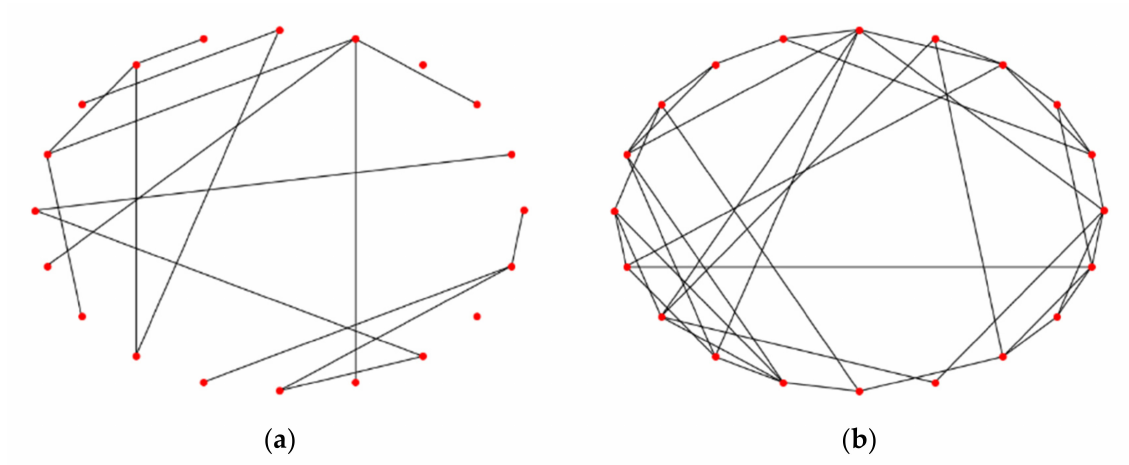
Figure 1. ( a ) E-R stochastic supply chain network; ( b ) WS small-world network.